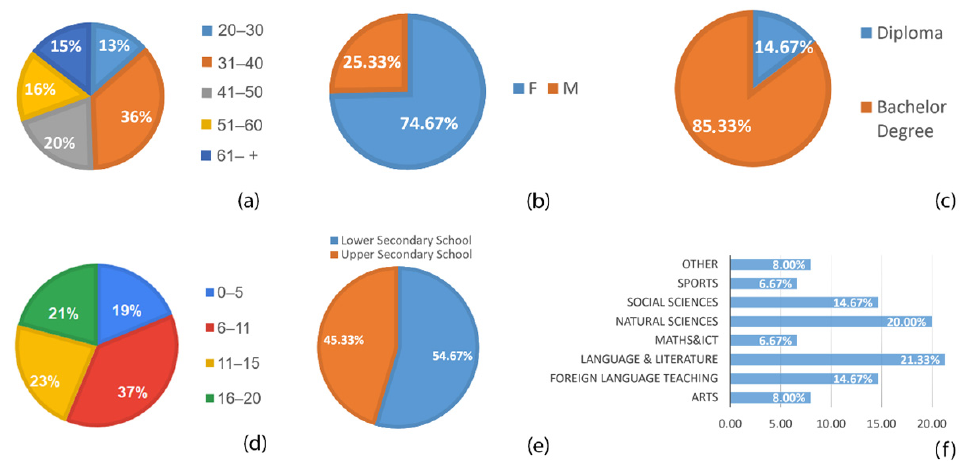
Figure 1. Teachers’ profile: ( a ) respondents’ age distribution; ( b ) gender distribution; ( c ) education level; ( d ) students’ age groups; ( e ) respondents’ secondary school level; ( f ) subjects taught.